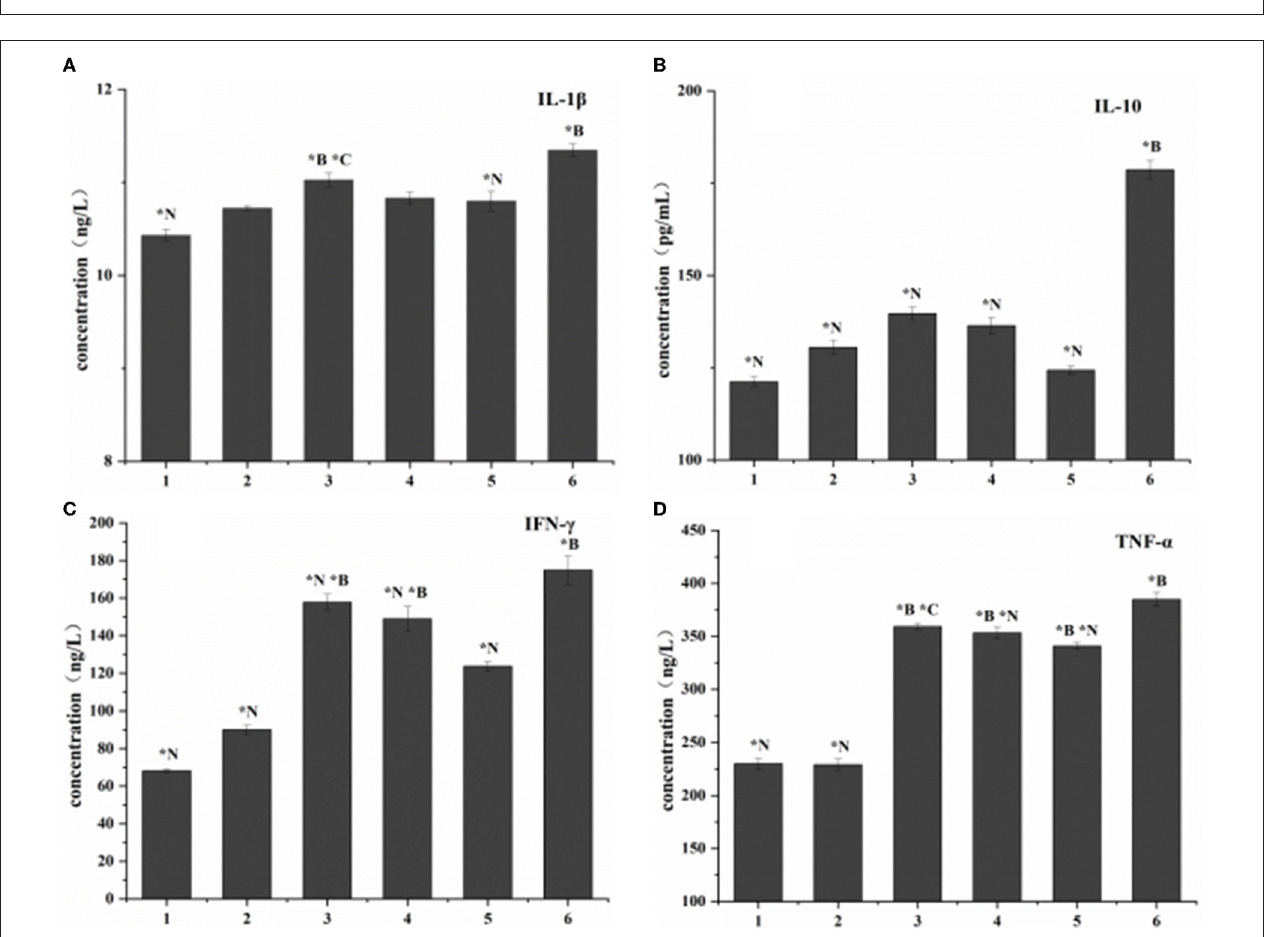
FIGURE 6 | Cytokine expression in listeriosis model. 1. Blank control group. 2. Toxic group. 3. Penicillin G sodium treatment group. 4. Phage therapy group. 5. Combination therapy group. 6. Non-intervention group. The values are means and standard deviations (SD) ( n = 5). *C <0.05. Each group vs. combination therapy group. *B < 0.05. Each group vs. blank control group. * N <0.05. Each group vs. non-intervention group.